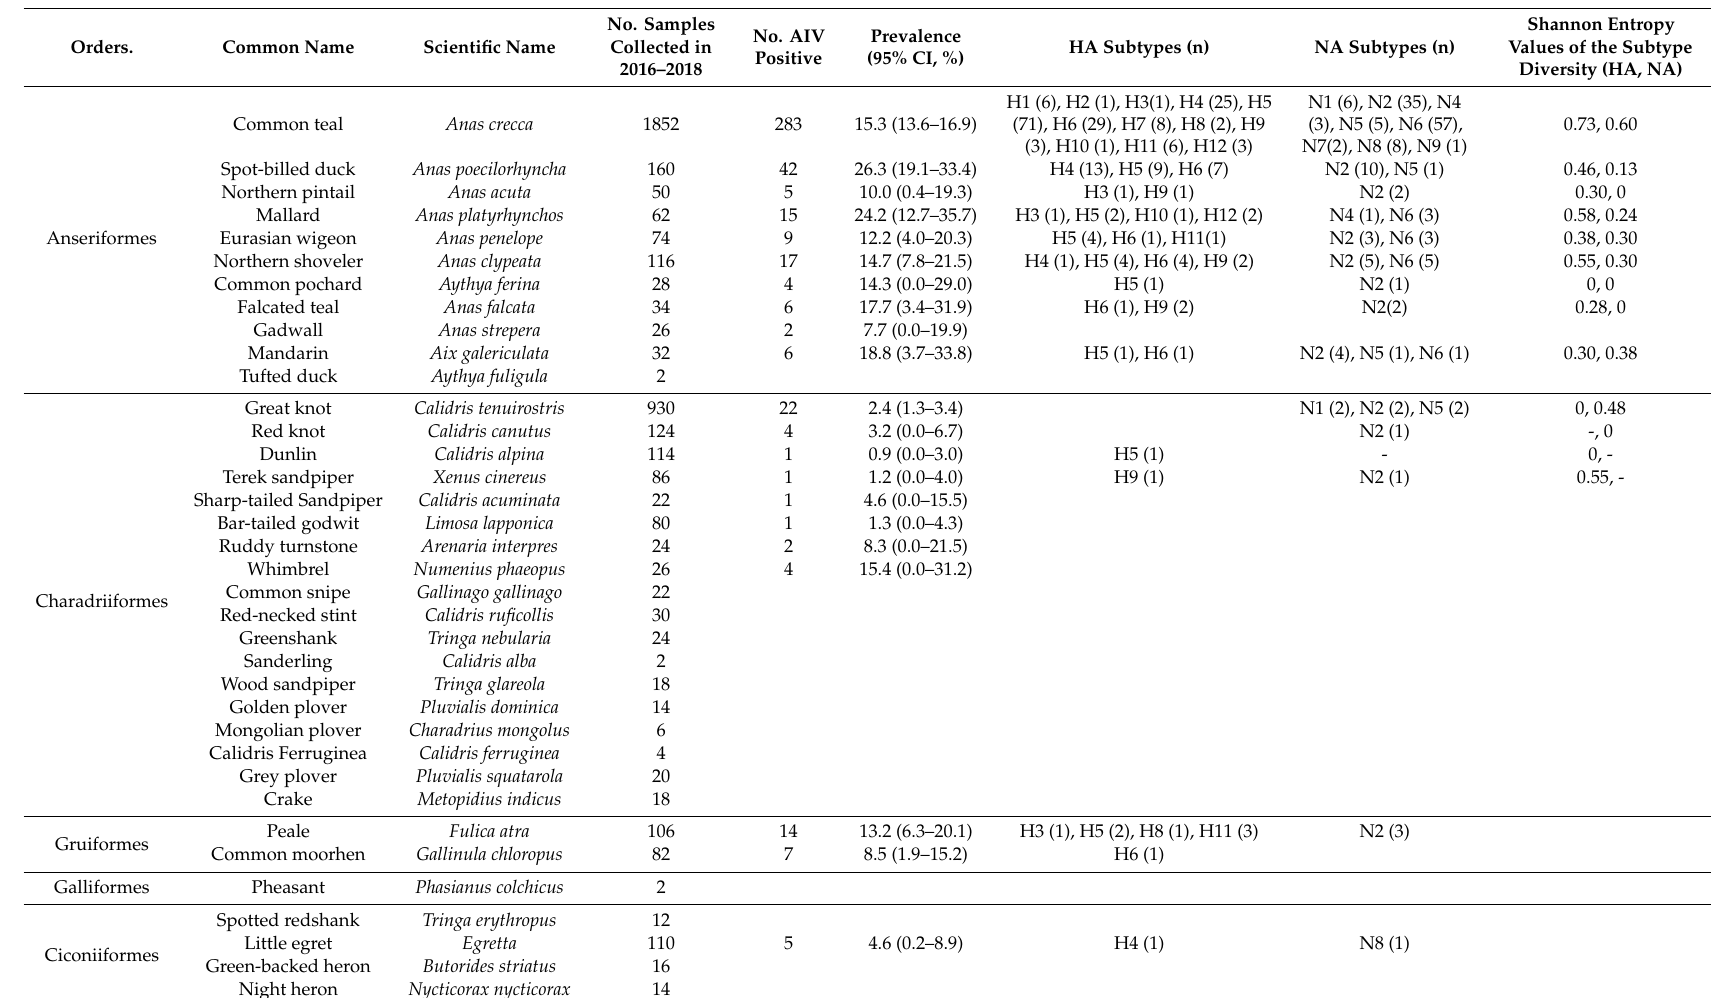
Table 2. Subtypes of influenza A viruses in wild birds in Shanghai,